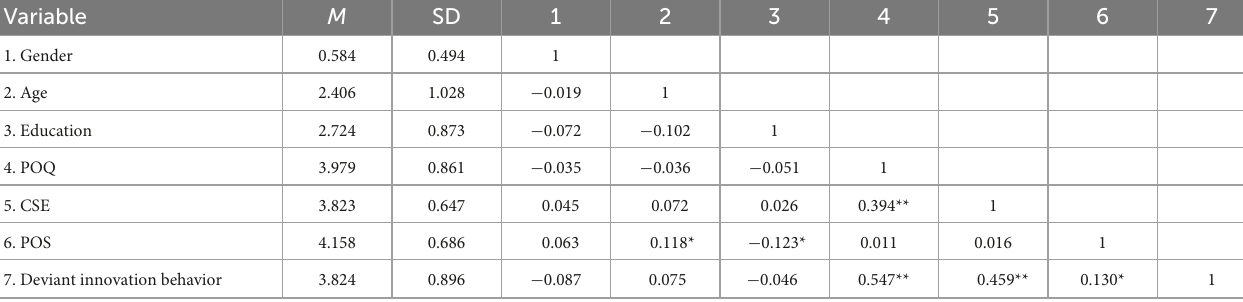
TABLE 3 Means, standard deviations, and correlations of all variables in the study.